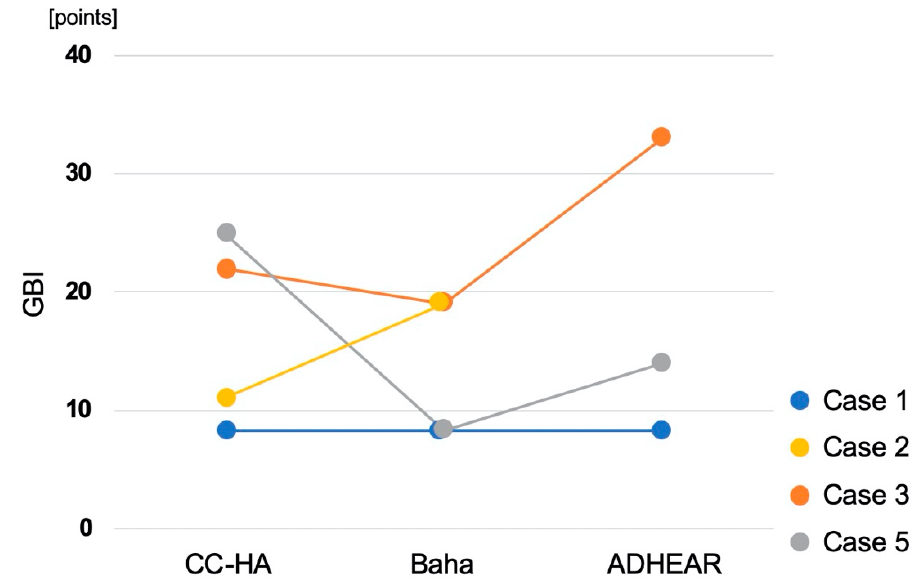
Figure 6. Results of Glasgow Benefit Inventory (GBI).